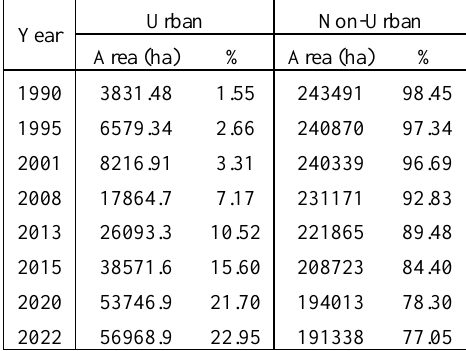
Table 3 . Urban and Non-Urban areas (ha) and their percentages in the study area from 1990 to